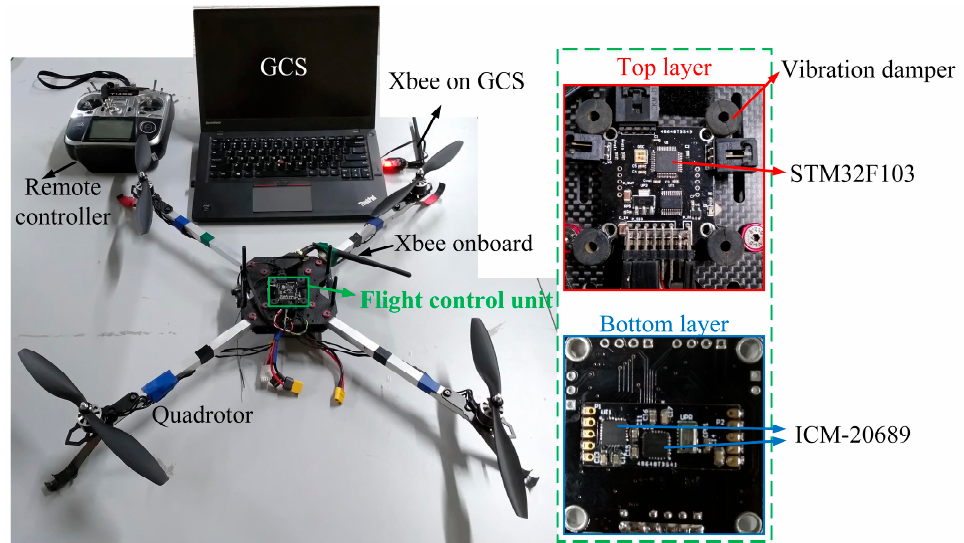
Figure 17 . Experimental system.